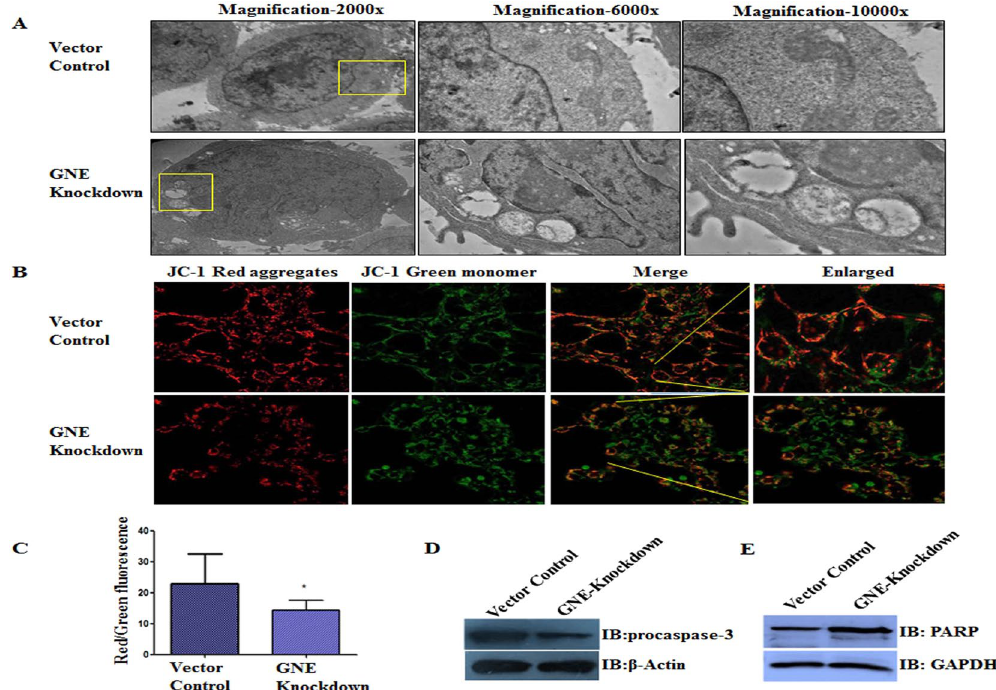
Figure 1. Effect of GNE knockdown on mitochondrial dysfunction: ( A ) Morpho-structural analysis of mitochondria: representative TEM image showing alterations in mitochondrial morphology of GNE knockdown cells, compared to vector control cells. ( B ) Effect of GNE knockdown on dissipation of mitochondrial membrane potential (as measured by JC-1) using confocal microscopy, magnification 60 × . Loss in mitochondrial membrane potential or depolarization is indicated by increased presence of JC-1 as monomeric form (green) and consequently leading to a decrease in the red/green fluorescence intensity ratio. ( C ) Histogram shows the ratio of red to green fluorescence intensity observed in GNE knockdown cell lines characterizing mitochondrial membrane potential. ( D ) Immunoblot analysis of cell lysates from indicated cell lines with anti-procaspase 3, β -actin was used as loading control. ( E ) Immunoblot analysis of cell lysates from indicated cell lines with anti-PARP antibody, GAPDH was used as loading control. The statistical significance was assessed by one-way ANOVA test. P values for * is <